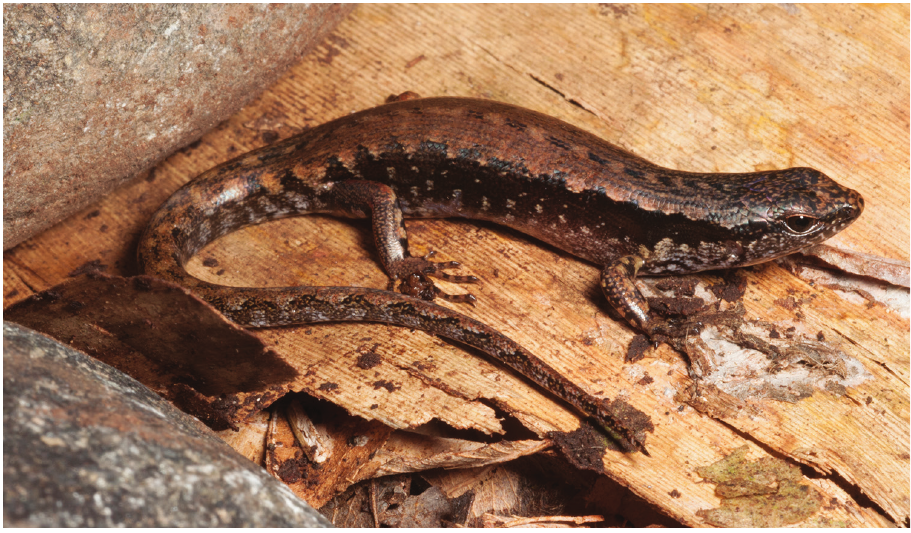
Figure 57. Parvoscincus kitangladensis male (KU 334078) from Eye Falls, Mt. Hilong-hilong, Municipality of Remedios T. Romualdez, Agusan del Norte Province. Photo: